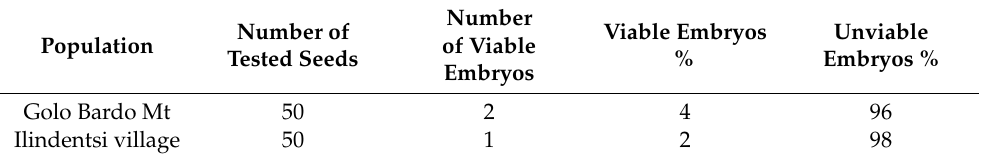
Table 1. Assessment of the seed (embryo) viability after TZ testing for seeds collected from the natural populations (in situ).